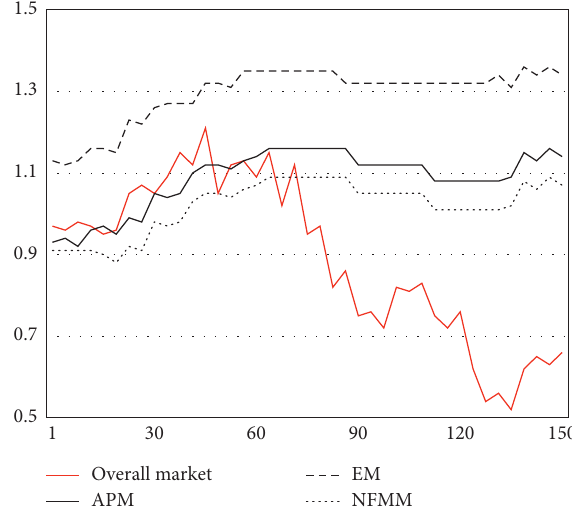
Figure 6: Income comparison against short-term transaction